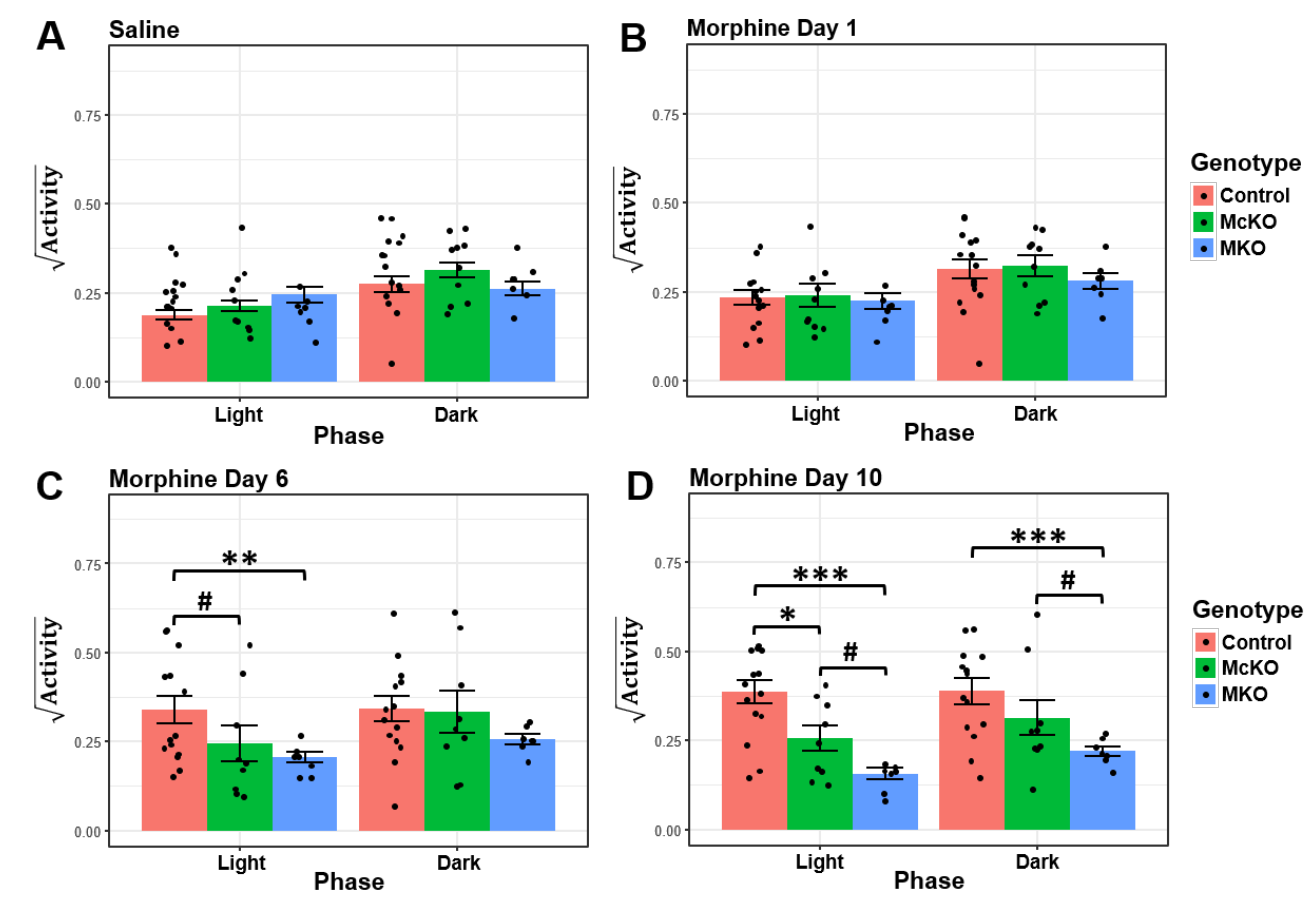
Figure 2. McKO mice exhibited reduced morphine-induced locomotor activation compared with control littermates following protracted morphine exposure. ( A ) Quantification of locomotor activity 1–2 h following saline injections at ZT0 and ZT12 for Control ( n = 15), McKO ( n = 10), and MKO ( n = 7) mice. ( B ) Quantification of horizontal activity 1–2 h following initial 20 mg/kg i.p. morphine injections at ZT0 and ZT12 for Control ( n = 15), McKO ( n = 10), and MKO ( n = 7) mice. ( C ) Quantifi- cation of horizontal activity 1–2 h following 20 mg/kg i.p. morphine injections at ZT0 and ZT12 for Control ( n = 14), McKO ( n = 9), and MKO ( n = 7) mice on day 6 of the morphine treatment paradigm. ( D ) Quantification of horizontal activity 1–2 h following 20 mg/kg i.p. morphine injections at ZT0 and ZT12 for Control ( n = 14), McKO ( n = 9), and MKO ( n = 7) mice on day 10 of the morphine treatment paradigm. Three-way ANOVA with a Holm–Bonferonni post hoc adjustment was performed on all pairwise comparisons (# p < 0.05, * p < 0.01, ** p < 0.001, *** p < 0.0001). Data presented as mean ± SEM .